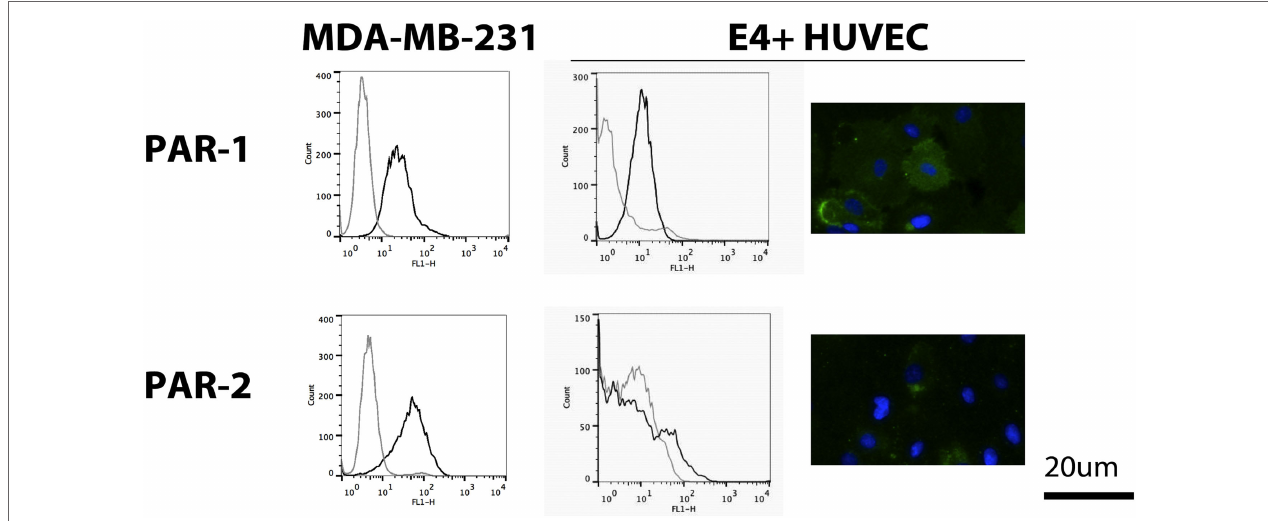
FigUre 2 | Protease-activated receptor (PAR) expression on E4 + human umbilical vein endothelial cells (HUVEC). Expression of PAR-1 and PAR-2 on E4 + HUVEC, using MDA-MB-231 breast cancer cells as a positive control, was evaluated using flow cytometry (black line: protein of interest; gray line: isotype control) and immunofluorescent microscopy (green: protein of interest; blue: nuclear